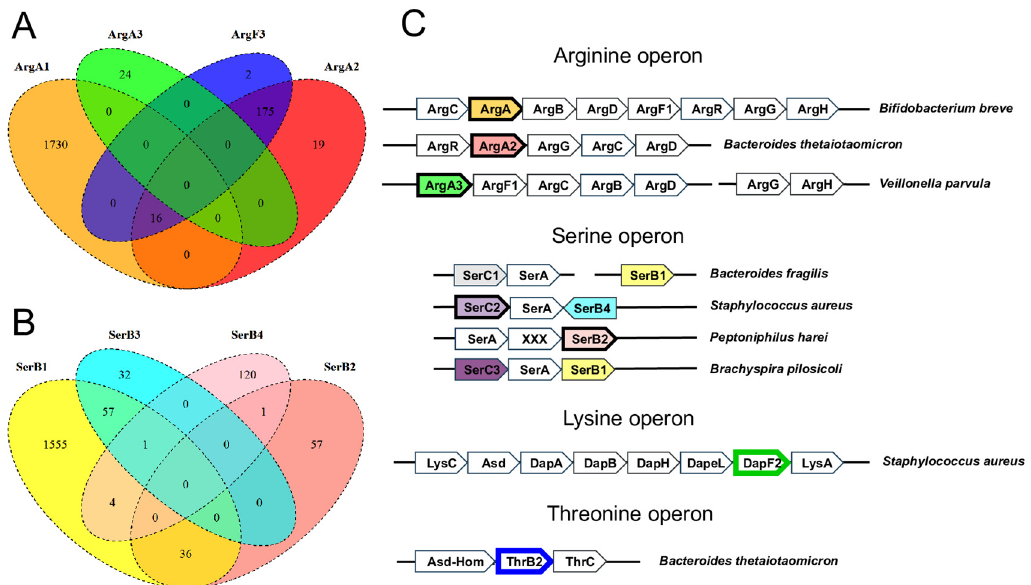
Figure 2. Genomic context of new non-orthologous enzymes in amino acid biosynthetic pathways. The Venn diagrams show co-occurrence of 4 different variants of N-acetylglutamate synthase ArgA ( A ), and phosphoserine phosphatase SerB ( B ). Gene co-localization is shown for selected genomes only ( C ).